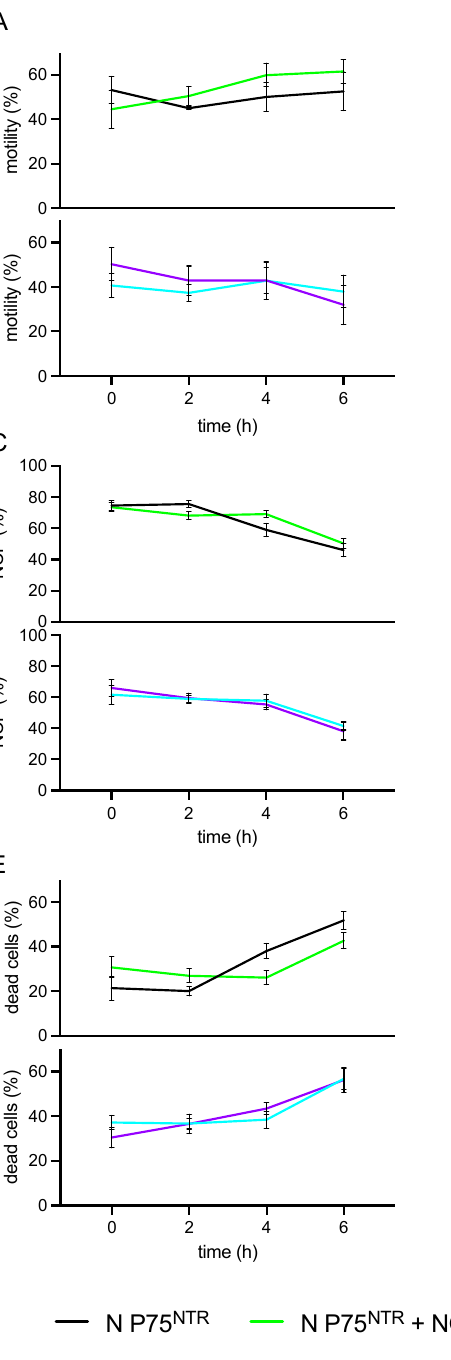
Figure 3. Effect of NGF treatments (100 ng/mL) on Normal and High p75 NTR cells during storage times (0, 2, 4, 6 h). ( A ) Motility rate (%); ( B ) Curvilinear velocity (VCL, µ m/sec); ( C ) Non-capacitated cells (NCP, %); ( D ) Capacitated cells (CP, %); ( E ) Dead cells (%); ( F ) Apoptotic cells (%). Sample size n = 40.